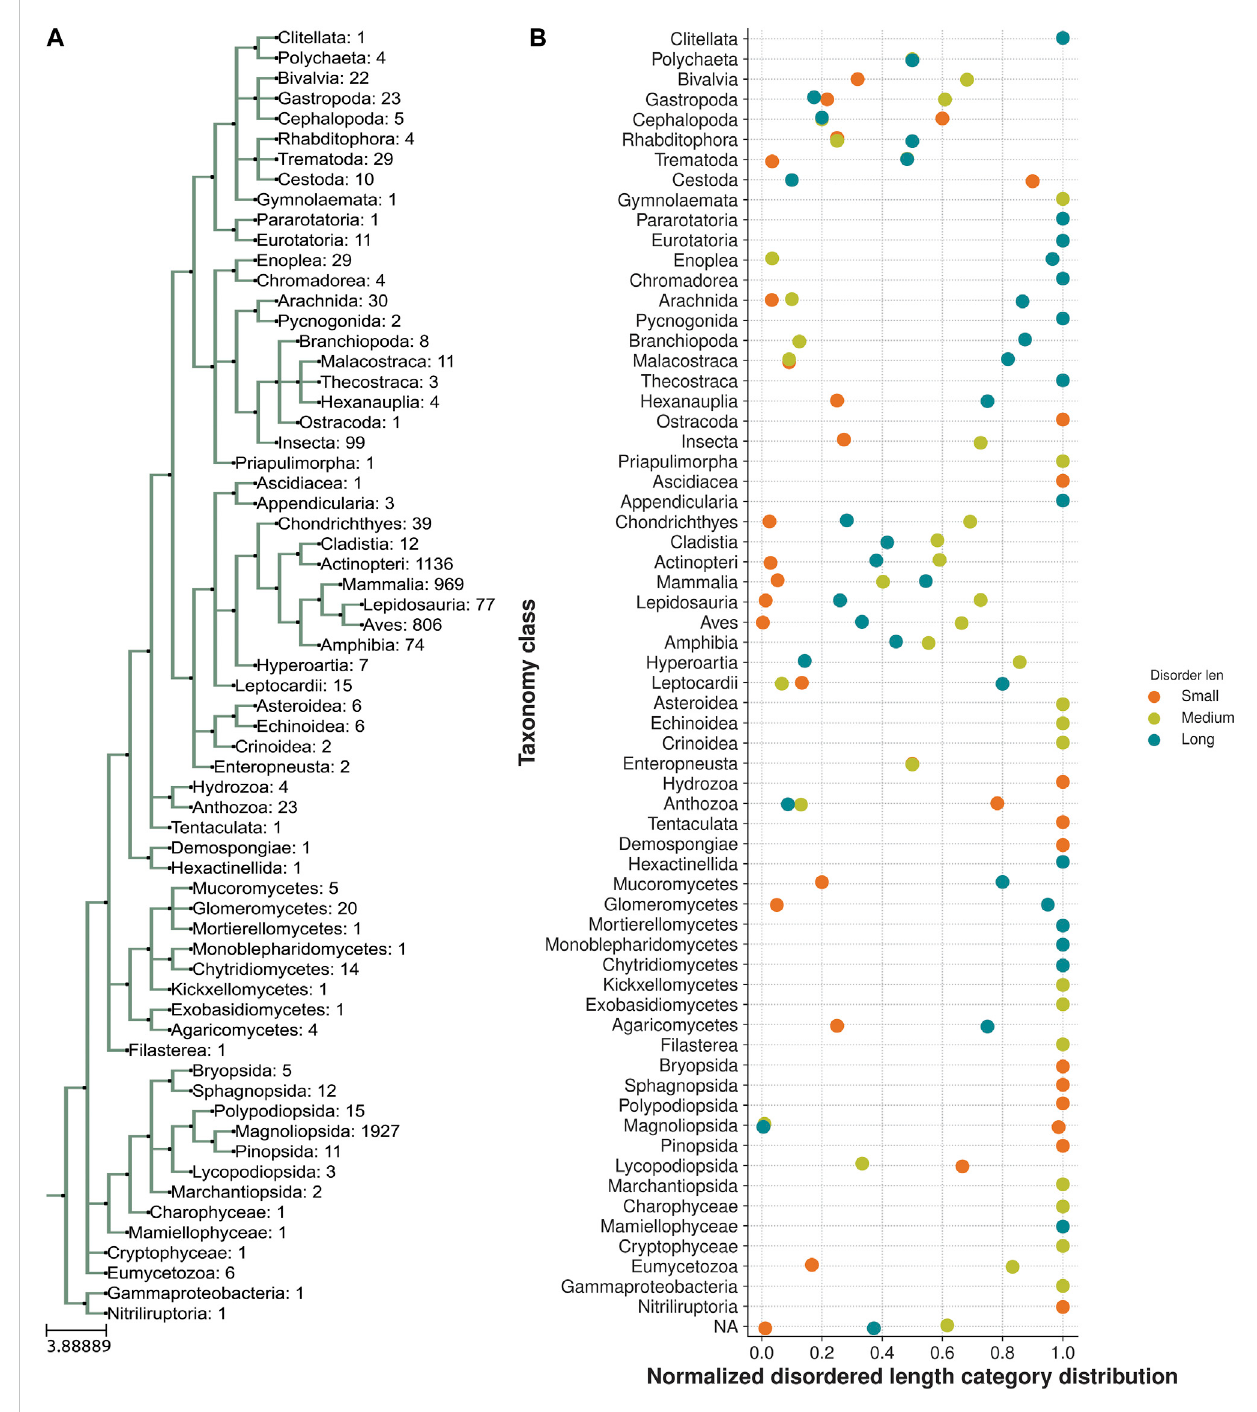
FIGURE 4 Taxonomicdistributionofatrimodaldisorderedlinkerregion. (A) ClasstaxalevelphylogenyofCSRP3homologsdepictingthenumberofsequences in each class. (B) Normalized frequency of trimodal distribution of the linker length in each